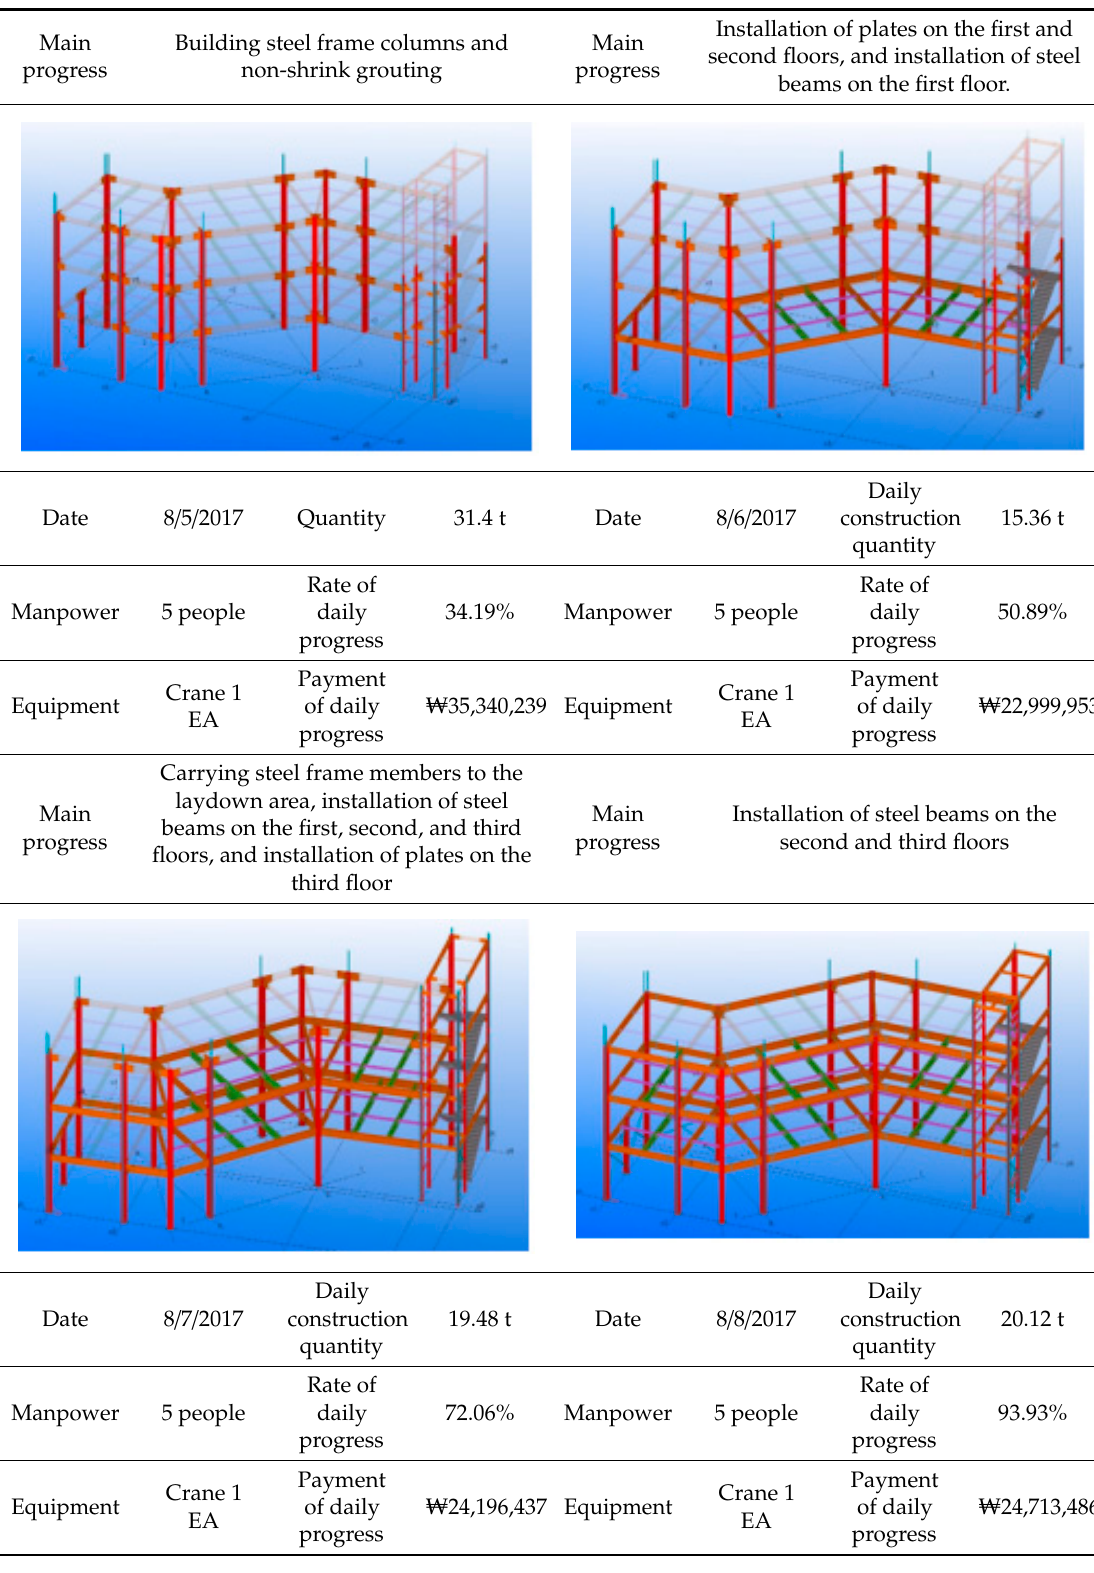
Installation of plates on the first and Main second floors, and installation of steel progress beams on the first